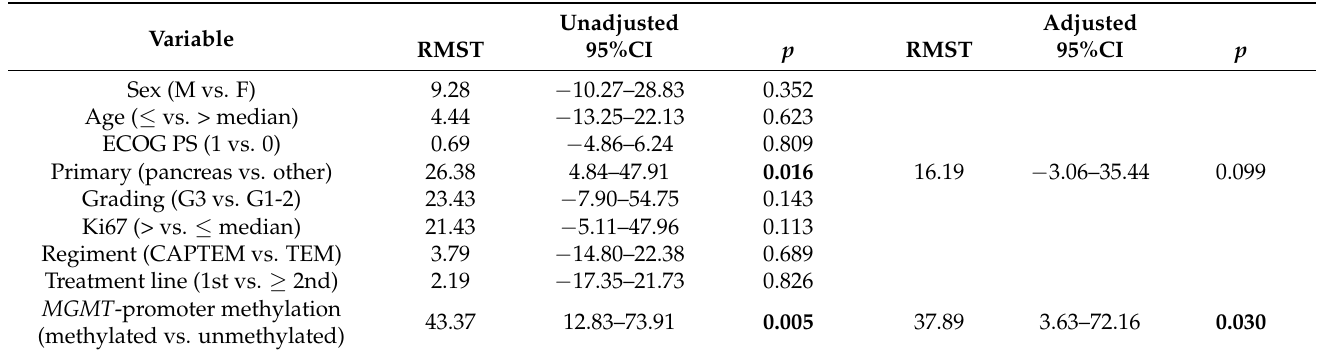
Table 4. Unadjusted and adjusted RMST difference for progression-free survival.